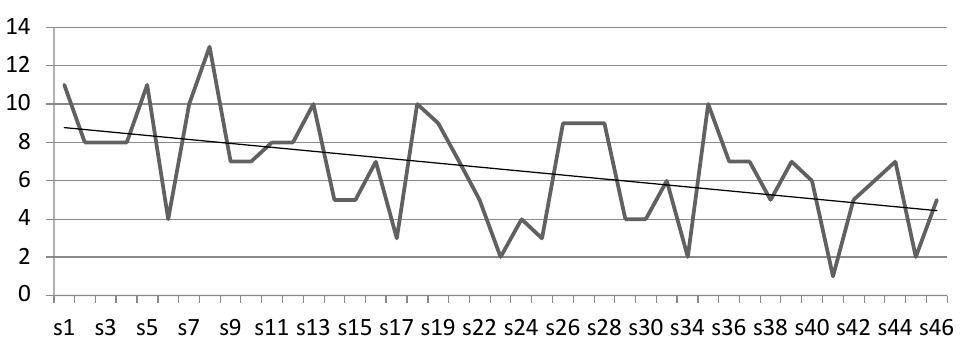
Graphic 4 . Repetition along the